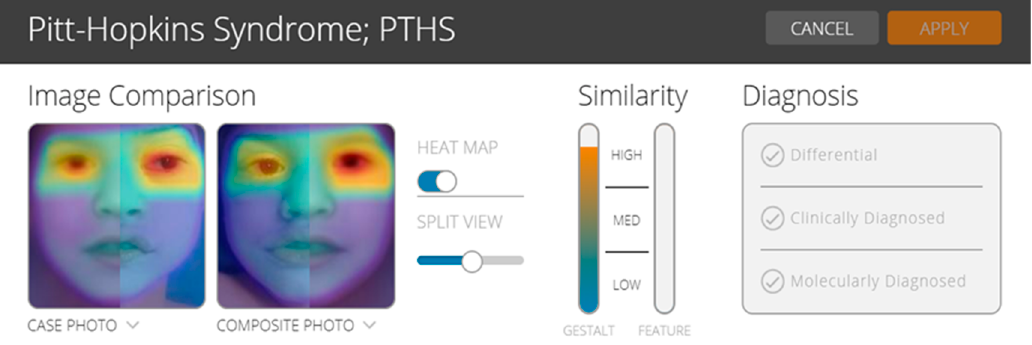
Figure 3. Face2Gene analysis based on a gestalt comparison. Personal archive.